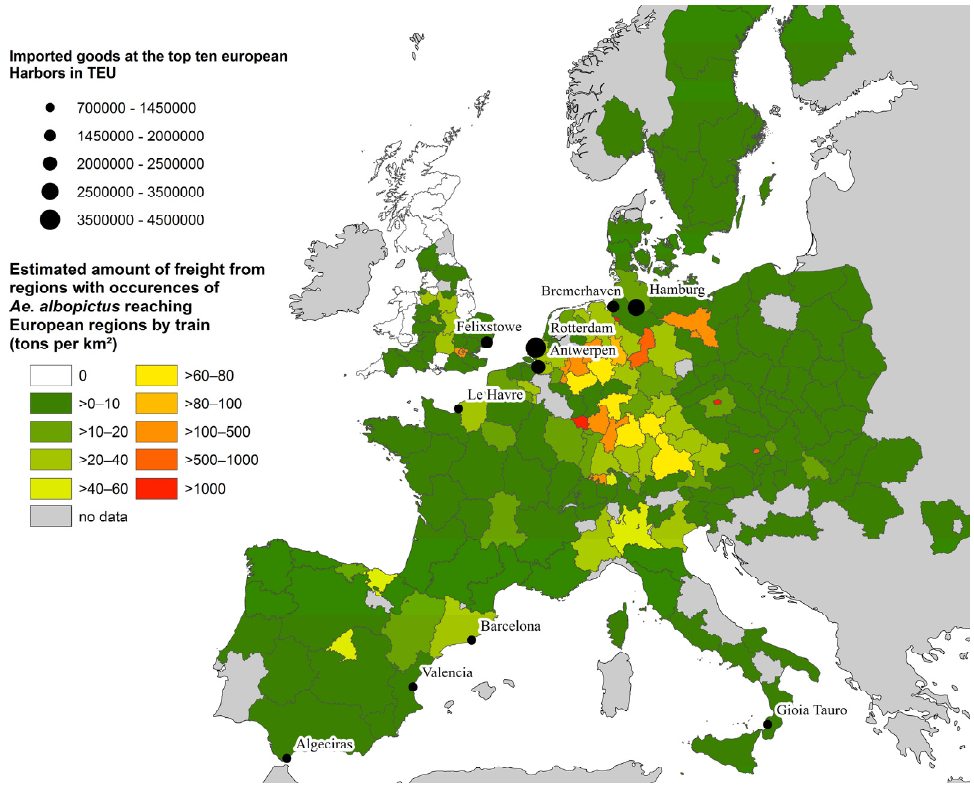
Figure 4. Transport of cargo from Aedes endemic countries from the top ten leading harbors by train to European NUTS2 regions (tons per